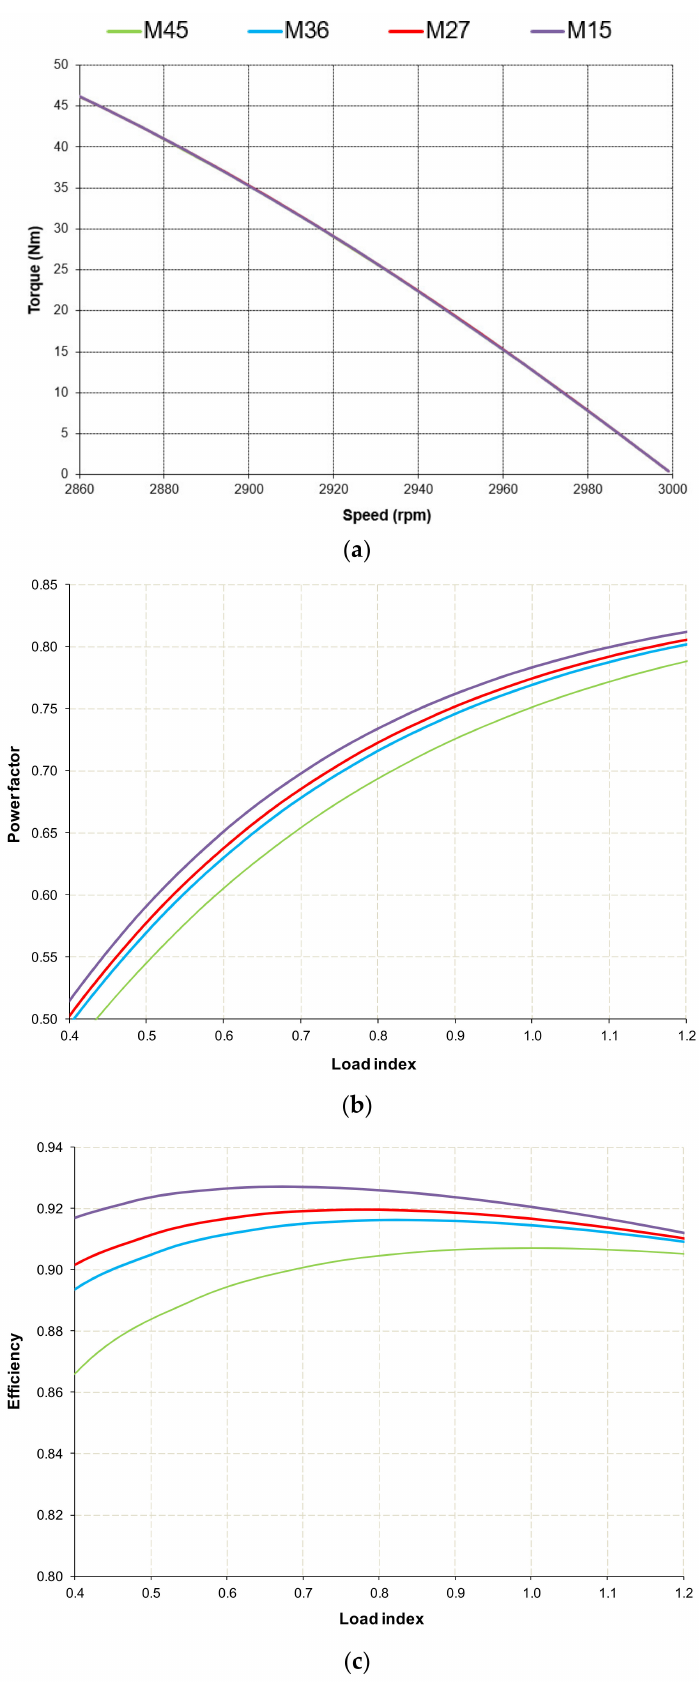
Figure 5. Characteristic curves in the 7.5 kW motor (variations of type of steel). ( a ) Torque-speed (stability zone), ( b ) Power factor-load index, ( c ) Efficiency-load